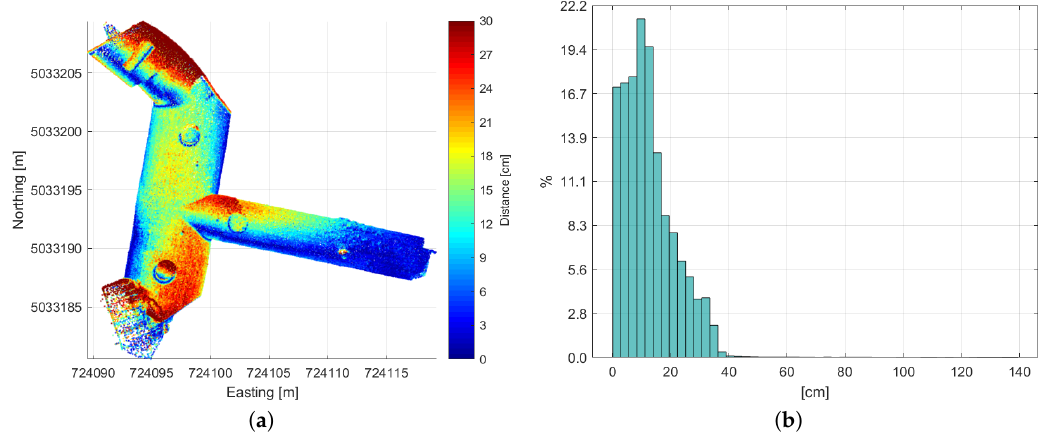
Figure 5. Leica Pegasus 3D model accuracy assessment: comparison with the TLS 3D model. Comparison of georeferenced point clouds (WGS84 UTM32). ( a ) Map of point-to-point distances. ( b ) Histogram of distances shown in ( a ). Table 3. Leica Pegasus 3D model accuracy assessment: absolute error with respect to TLS 3D